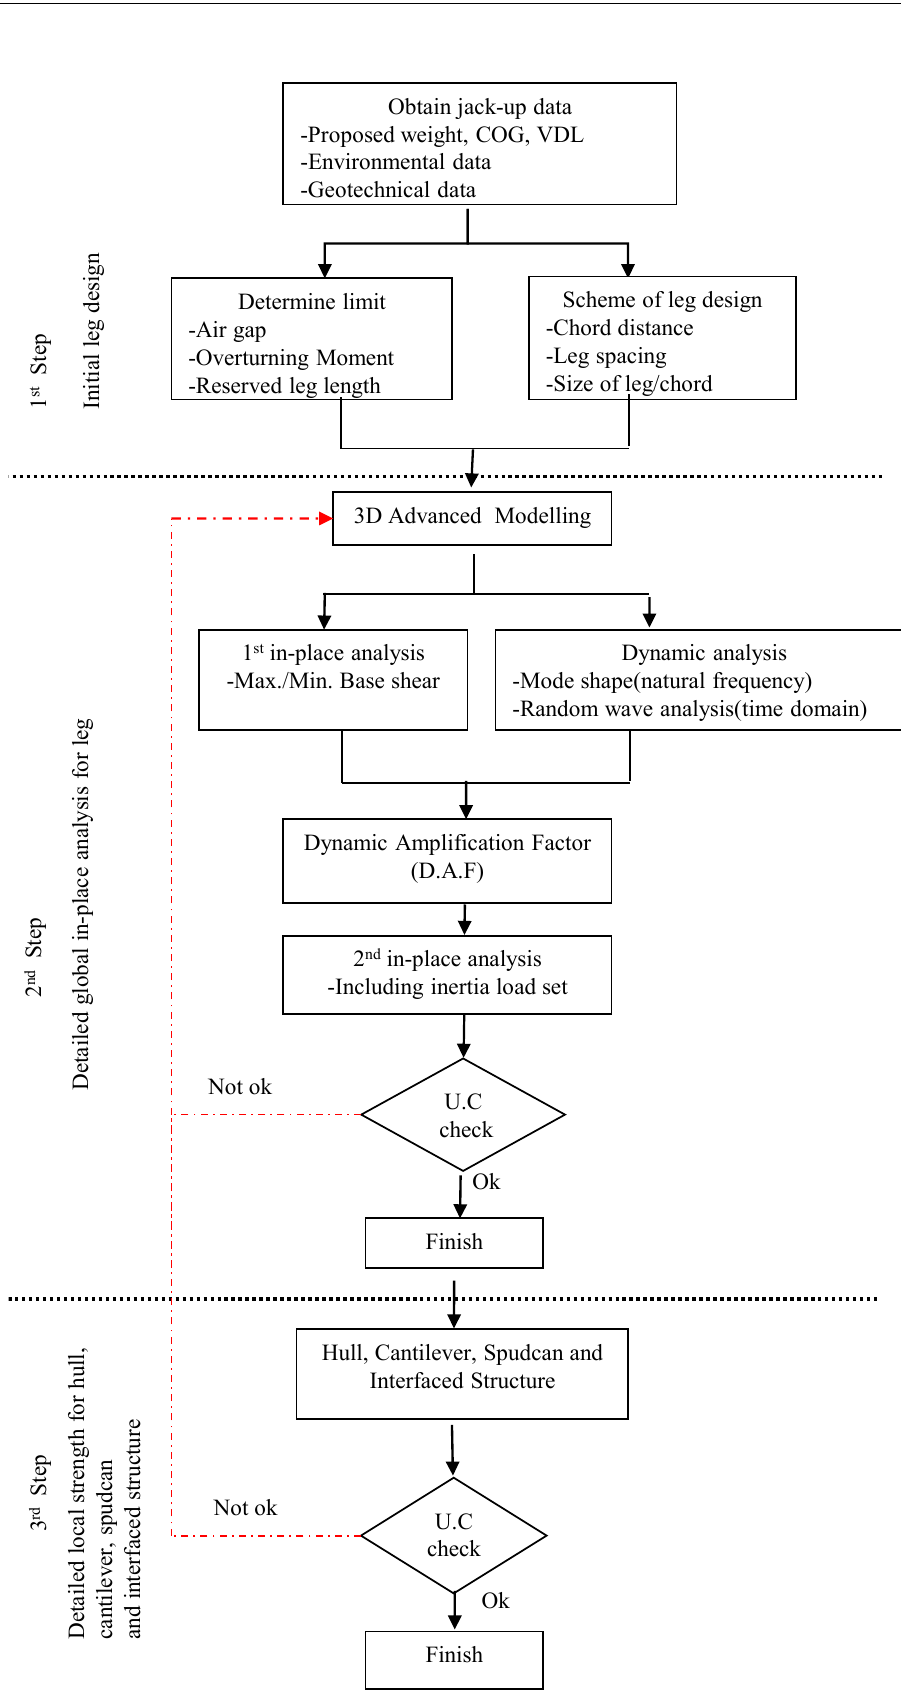
Figure 5. Analysis flow-chart of both global and local structures .